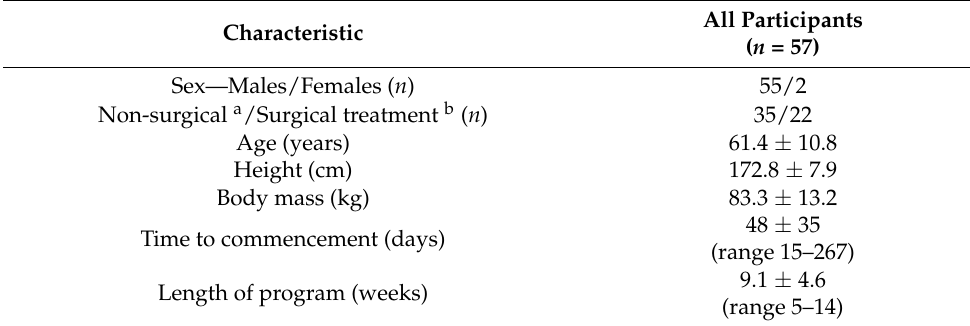
Figure 1. Flow of participants through study. CR, cardiac rehabilitation. Table 1. Demographic and anthropometric characteristics of study participants (mean ±